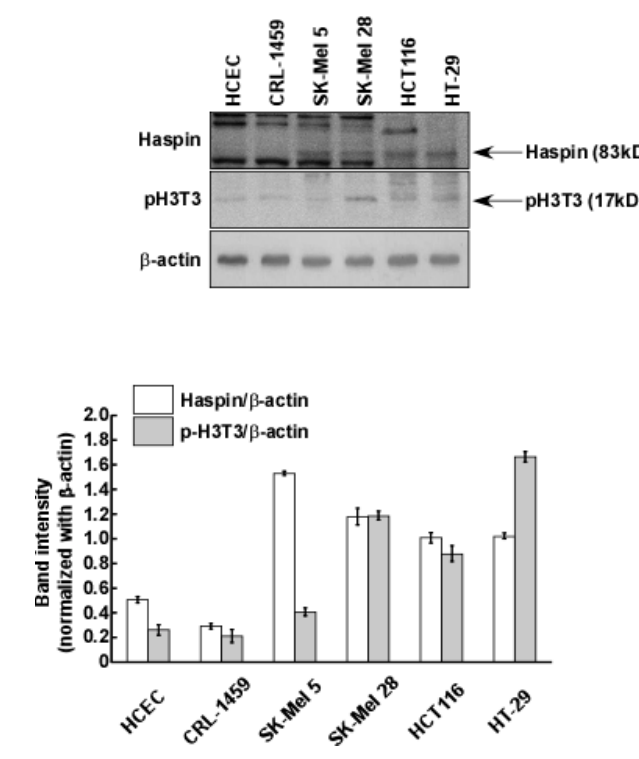
Figure 3. Haspin kinase is overexpressed and histone H3 is phosphorylated in cancer cells compared to normal cells. Protein levels were detected with the specific primary antibodies. Data are representative of three independent experiments, which gave similar results.